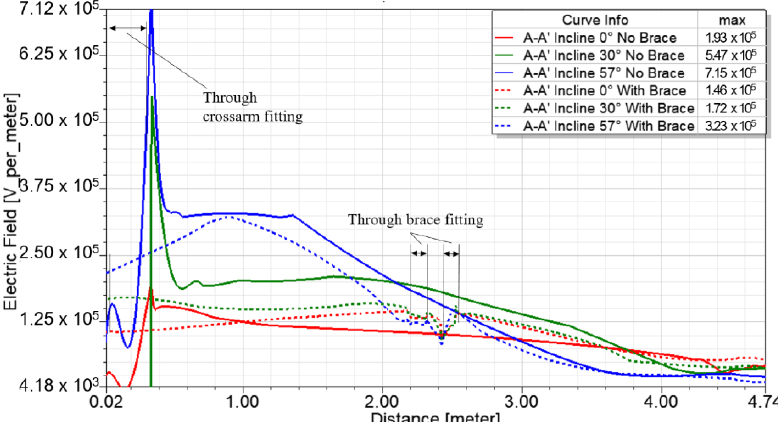
Figure 20. E-Field strength (measured at A–A’) due to di ff erent swing angles.